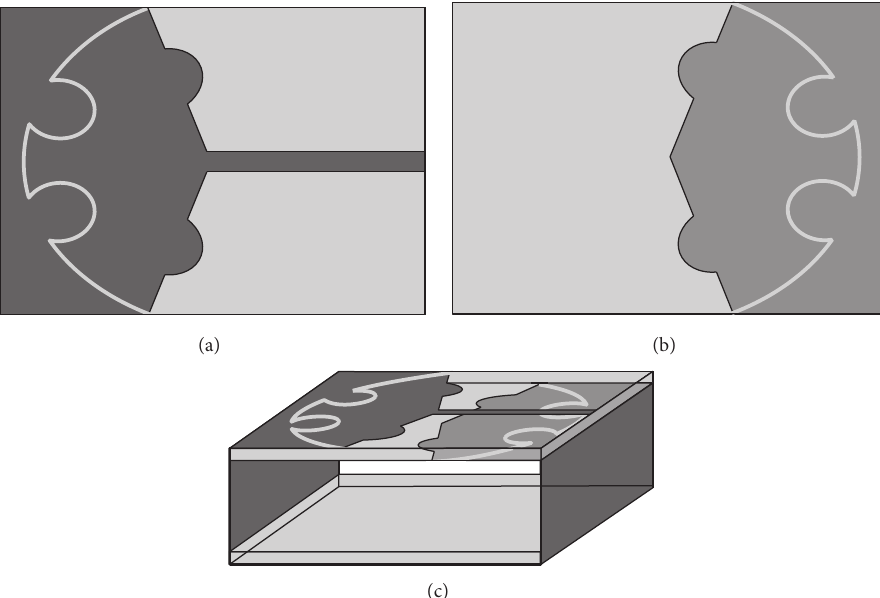
Figure 35: Geometry of a compact directional three-dimensional folded antenna for UWB applications [54]. Top view (a), bottom view (b), and tridimensional view (c).